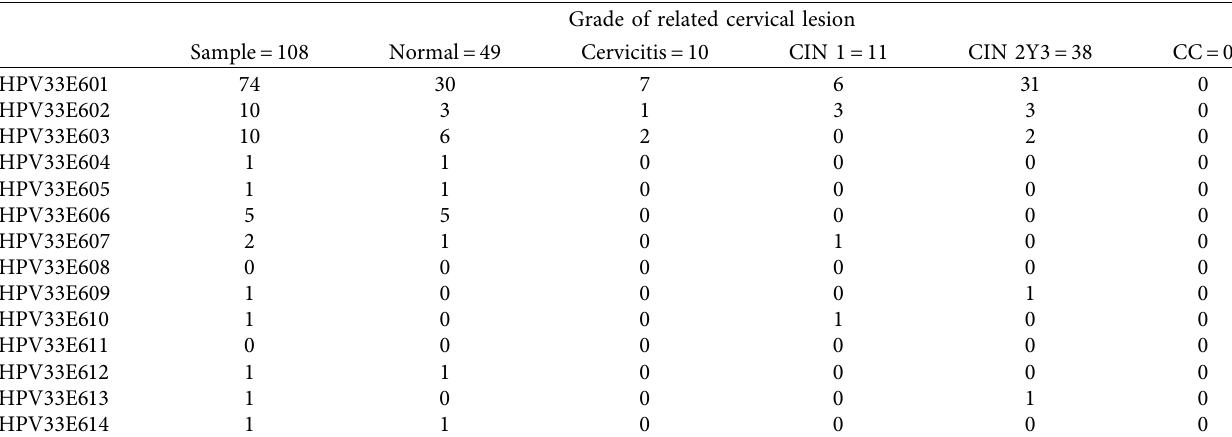
Table 8: Te associations of HPV33E6 variants with cervical